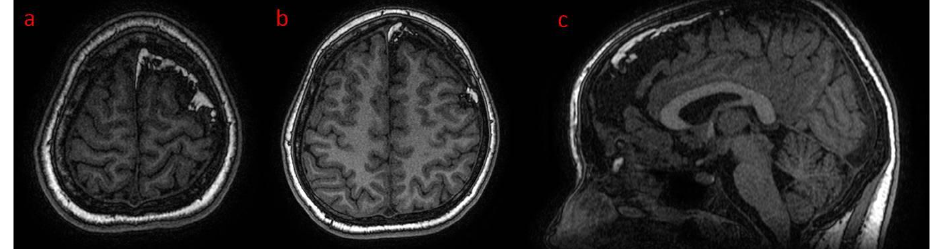
Figure 5. ( a – c ) Patient 2. Brain MR ( a , b ) axial T1- left-sided meningeal lipomatosis; ( c ) sagittal T1—minimal space enlargement without arachnoid cyst with lipomatous tissue.